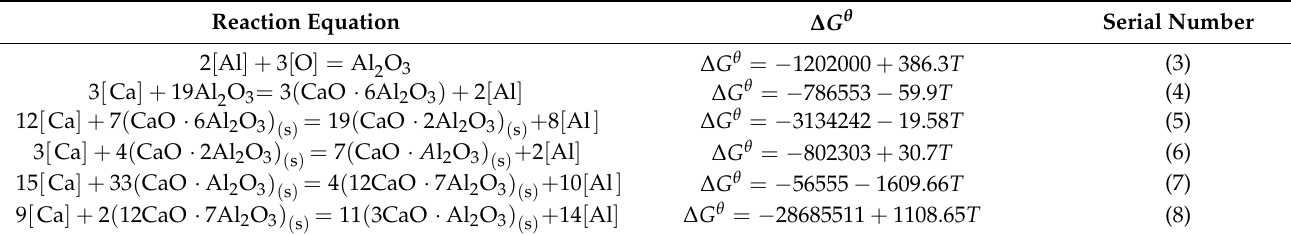
Table 5. The equilibrium constants of compound